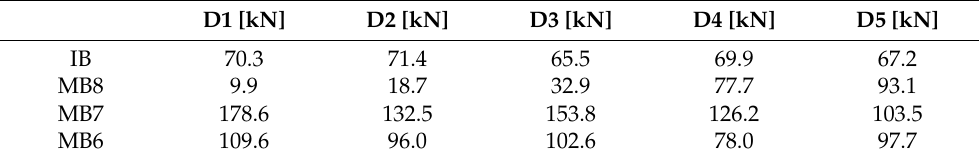
Table 4. Jack-up measurement